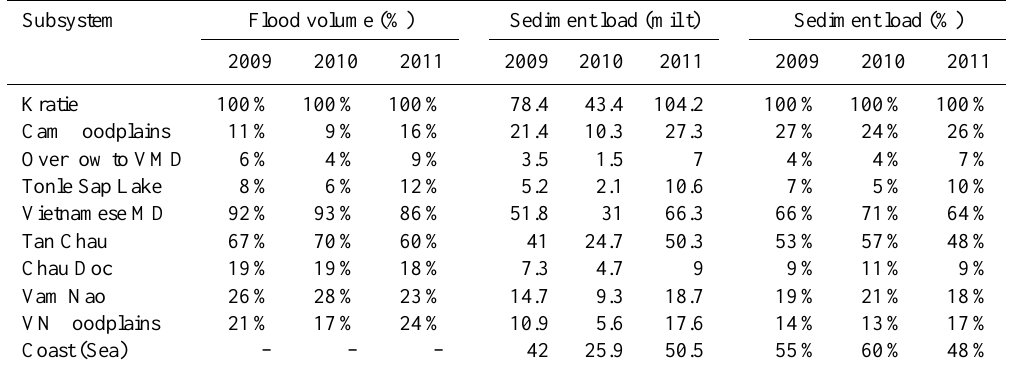
Table 3. Total sediment load, relative sediment load, flood volume (with reference to Kratie) at key locations in the MD for three flood